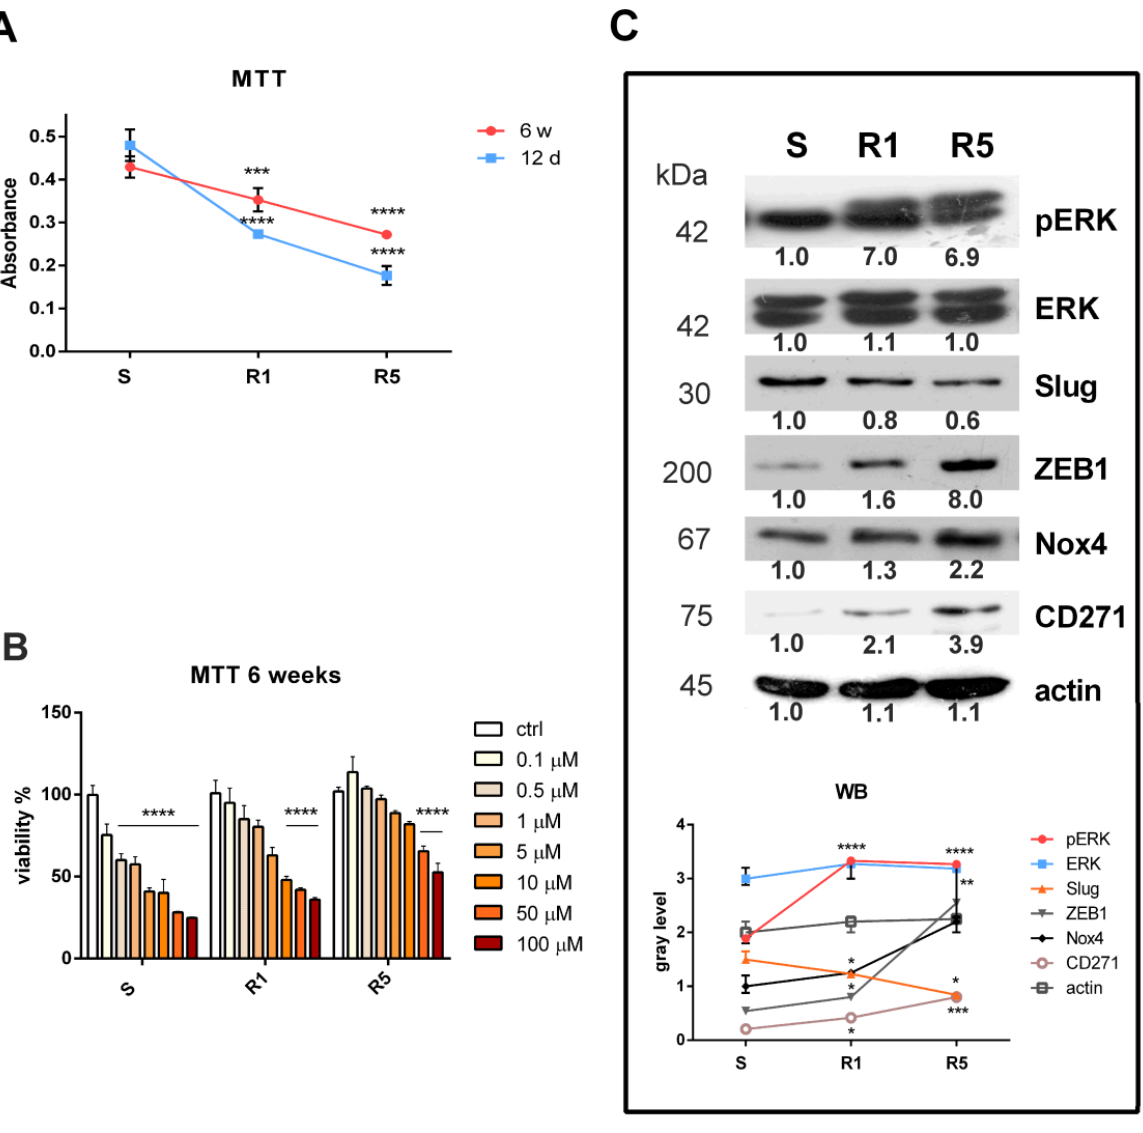
Figure 1. Characterization of BRAF-mutated melanoma cell line induced to resistance to vemurafenib. ( A ) Graph showing viability test with MTT assay measured in SK-MEL-28 cells induced or not induced to resistance with method 1 (R1) or method 2 (R5) for 12 days or 6 weeks. *** p -value < 0.001; **** p -value < 0.0001. ( B ) Graph showing resistance test with MTT assay measured in SK-MEL-28 cells (sensitive (S) or R1 or R5) (after 6 weeks) treated with vemurafenib from 0.1 up to 100 µ M for 3 days. **** p -value < 0.0001. ( C ) Western blot analysis of total lysate of S, R1, and R5 SK-MEL-28 cells revealed with anti-p-ERK (R1 and R5 **** p -value < 0.0001), normalized to anti-ERK, anti-Slug (R5 * p -value < 0.05), anti-ZEB1 (R1 p -value < 0.05; R5 ** p -value < 0.01), anti-Nox4 (R1 p -value < 0.05; R5 p -value < 0.01), anti-CD-271 (R1 p -value < 0.05; R5 *** p -value < 0.001) and anti-actin, as a loading